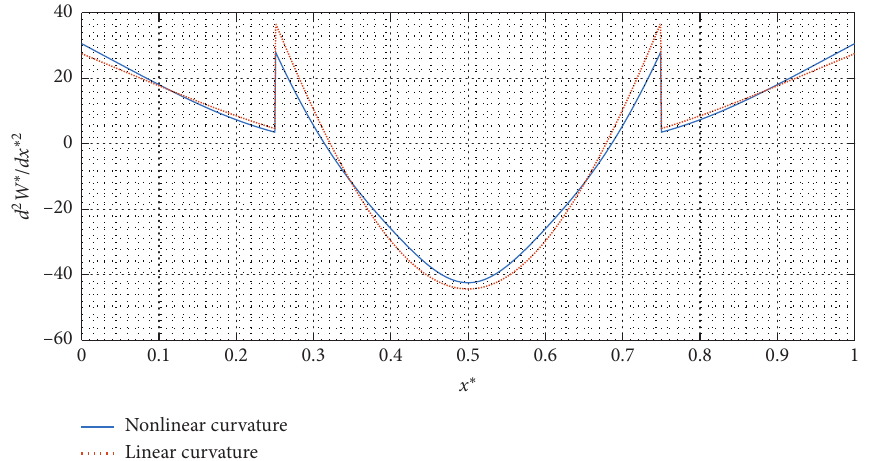
Figure 8: The curvature distribution of beam (b). Maximum nondimensional amplitudes ( W ∗